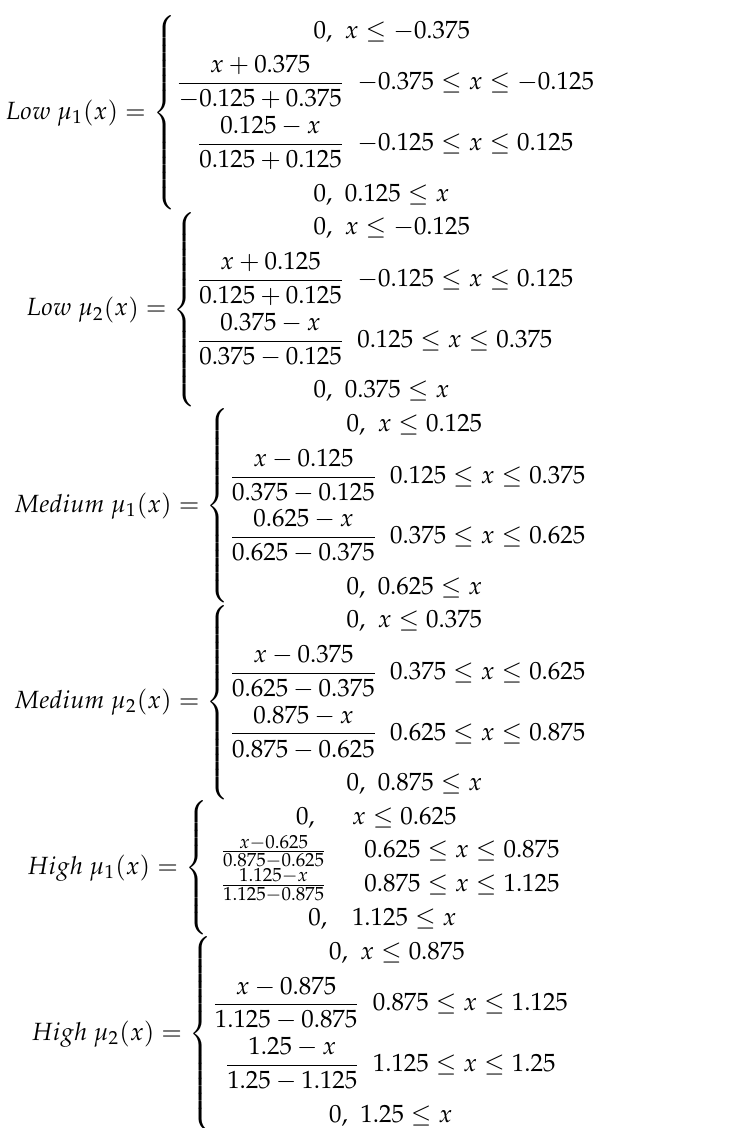
Figure 7. Rules for FGSO1 and FGSO1T2.